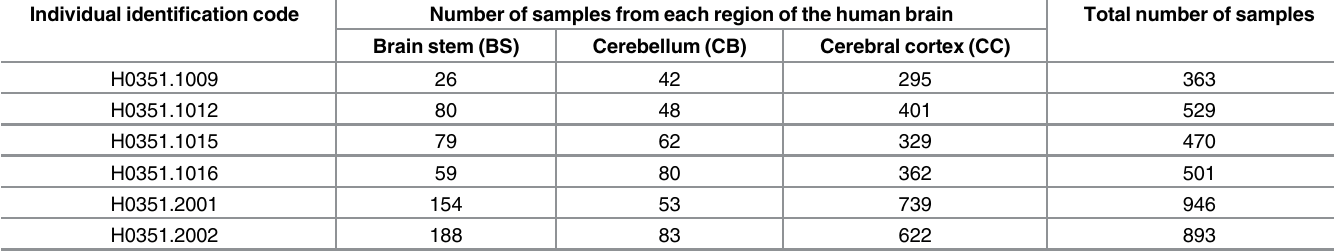
Table 1. The distribution of samples, obtained from six individuals, among three regions of the human brain. Individual identi fi cation